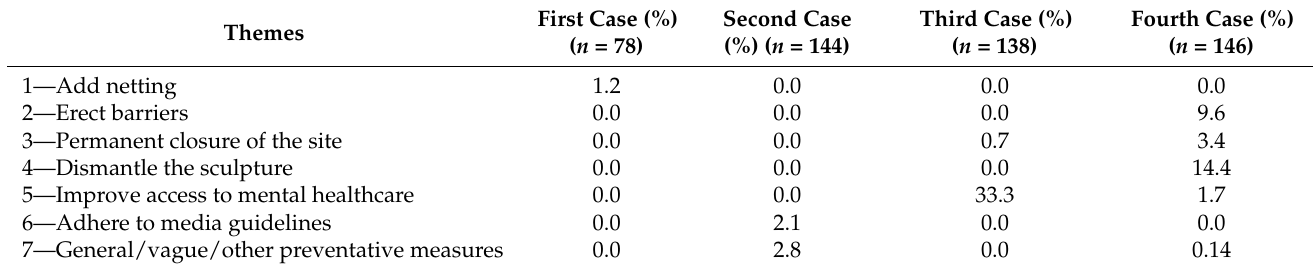
Table 3. Summaries of the distribution of suggestions of suicide preventative